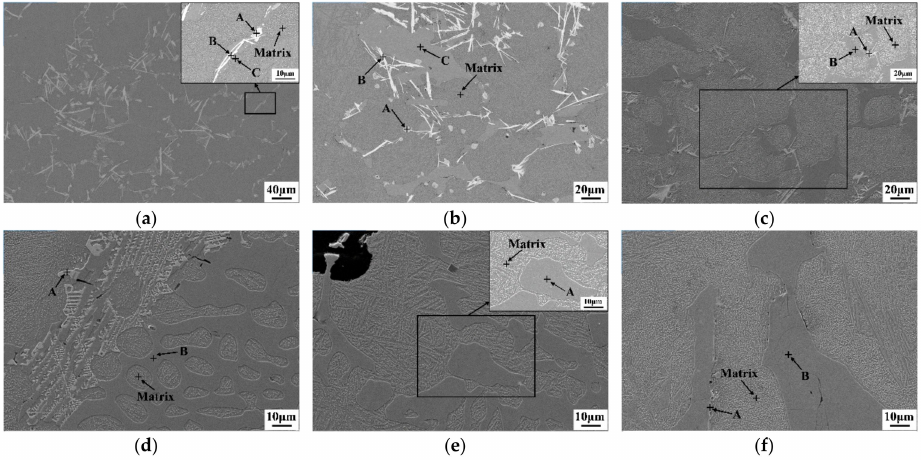
Figure 8. Carbides morphology in different positions of bimetallic transition zone. ( a – f ) → HSS side to DCI